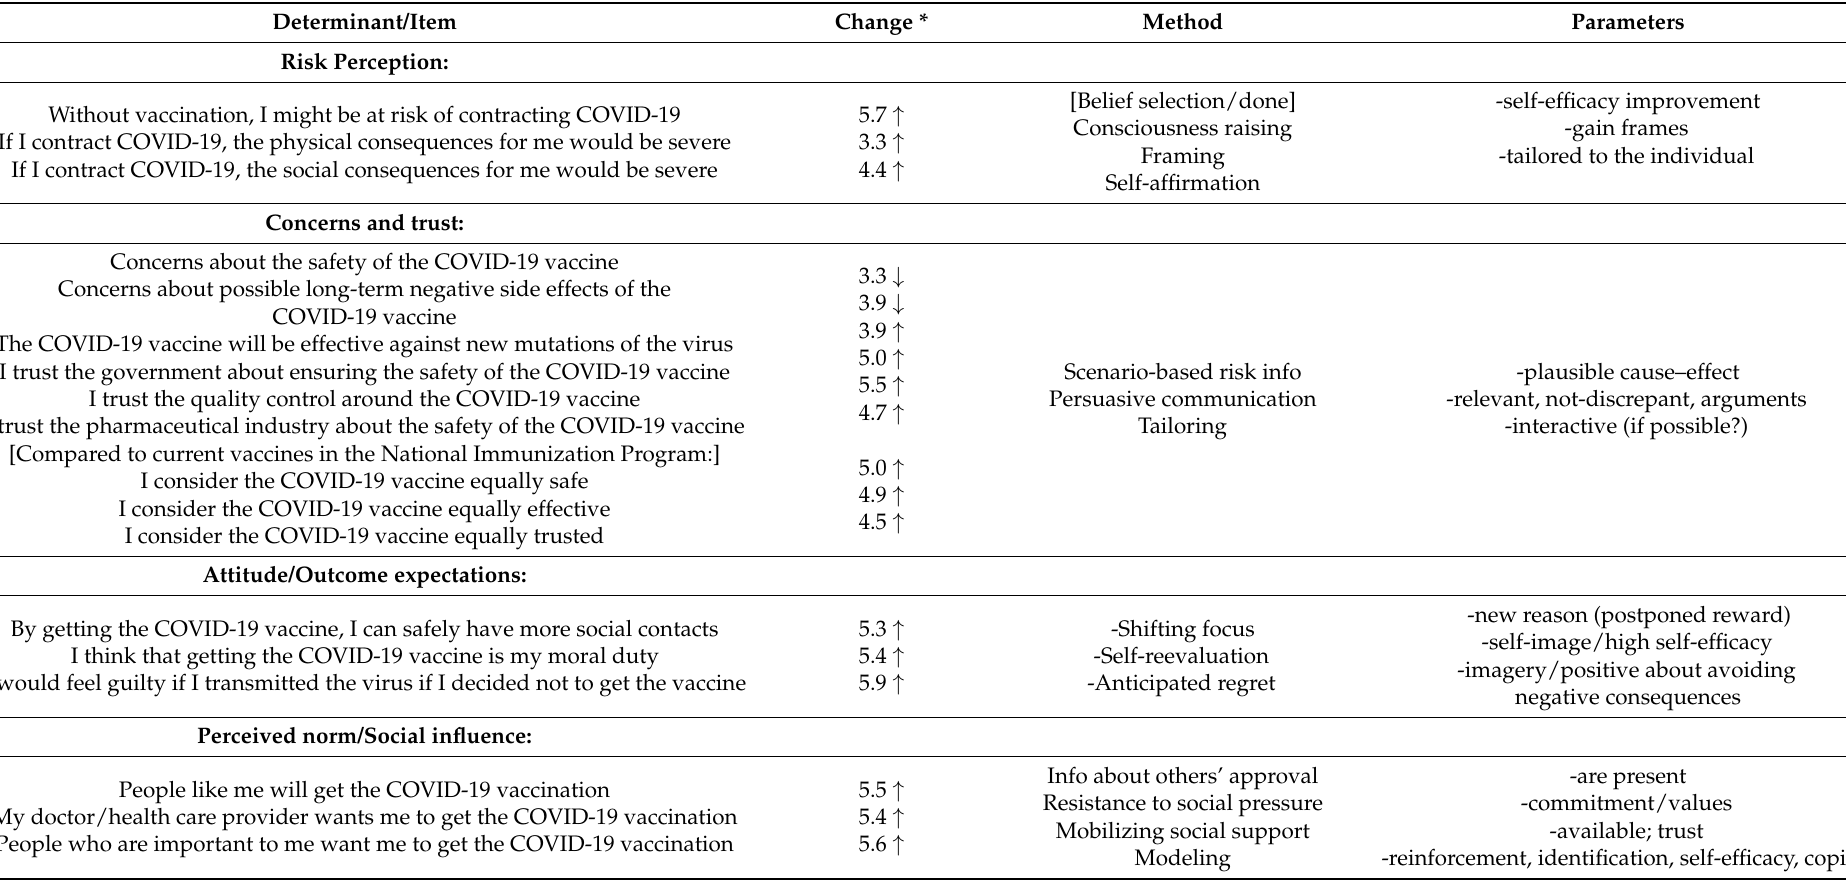
Table 2. An example of pairing the relevant determinants with behavior change principles to target in